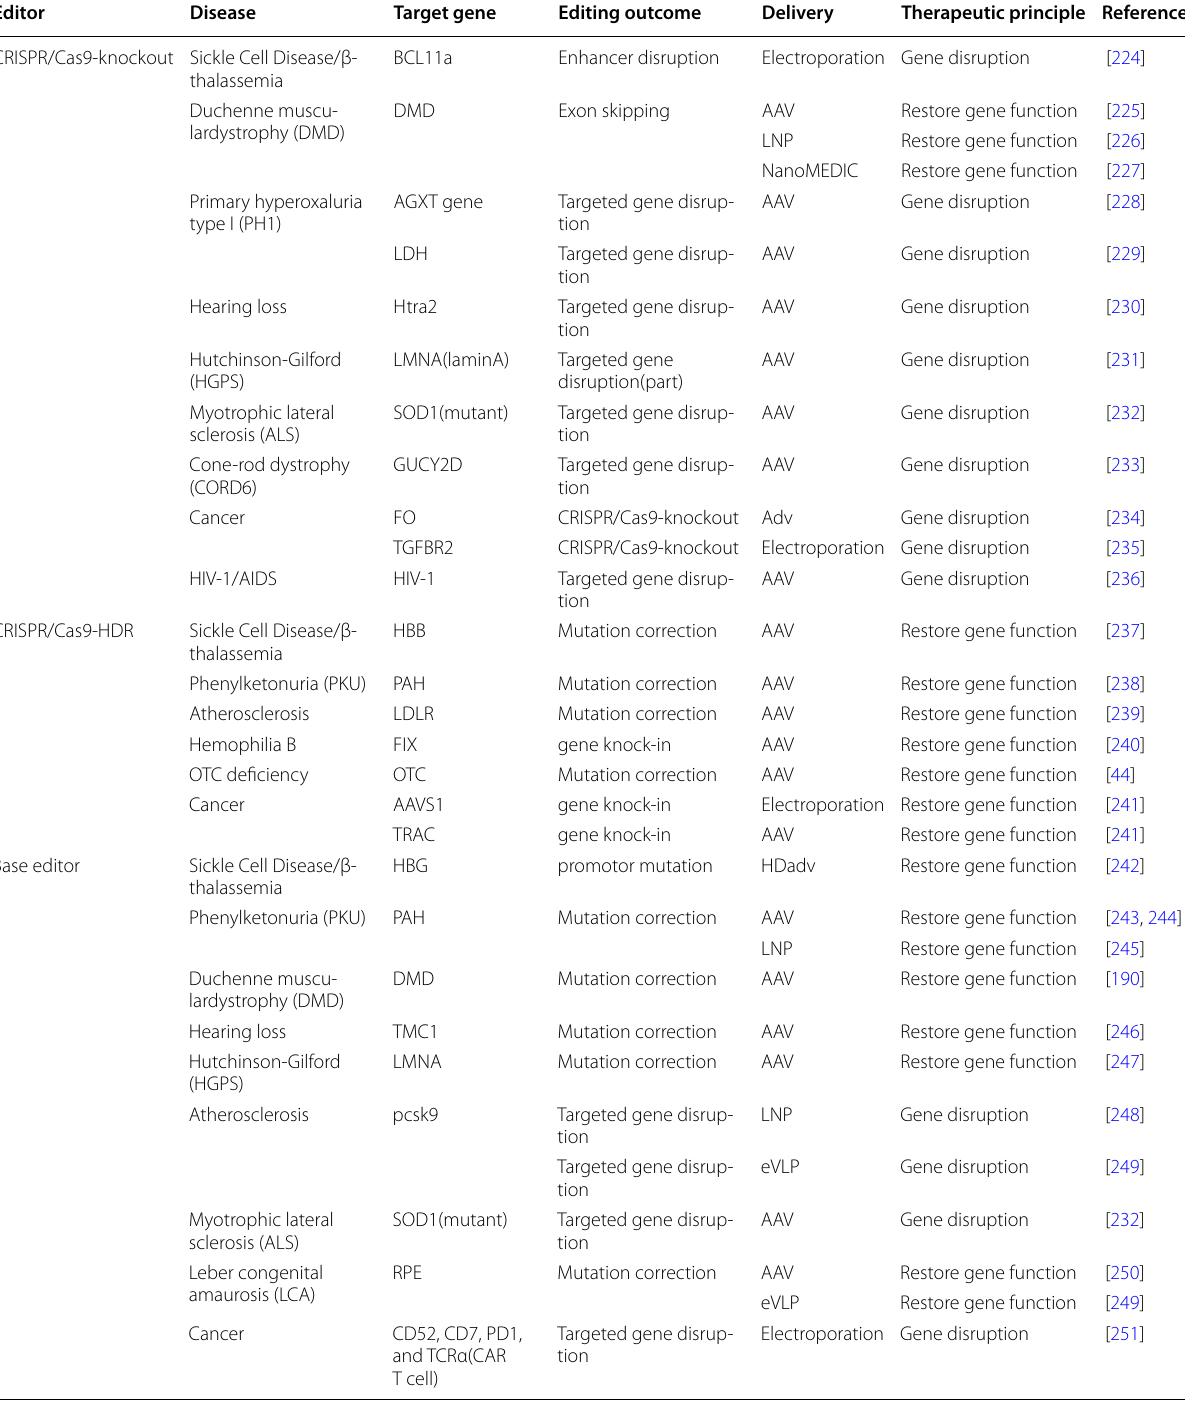
Table 3 Representative preclinical CRISPR/Cas9 therapy in inherited disease